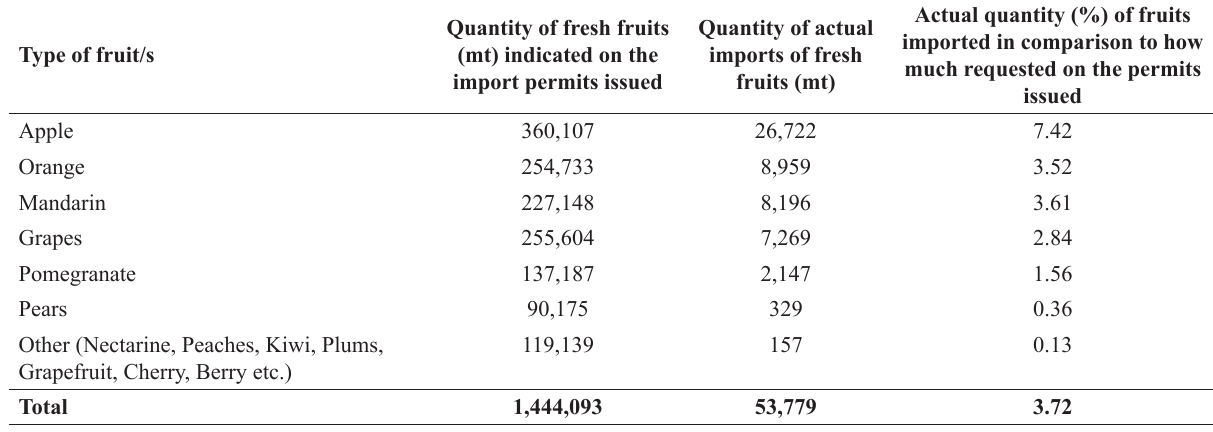
Figure 3: Important statistics regarding the fruit importations to Sri Lanka (2016-2018). A: The proportions of the fruits imported by the companies/people (one-six represents the company/person IDs) [six companies mainly run the importations; B: The source countries and the proportions – fruit imports; C: The proportions of the apple imported by the companies/people (one-six represents the company/person IDs comparable with Graph A); D: The source countries and the proportions – apple imports. Table 3: The quantities of apples requested to be imported in comparison to the other fruit types in 2017 and the actual quantities